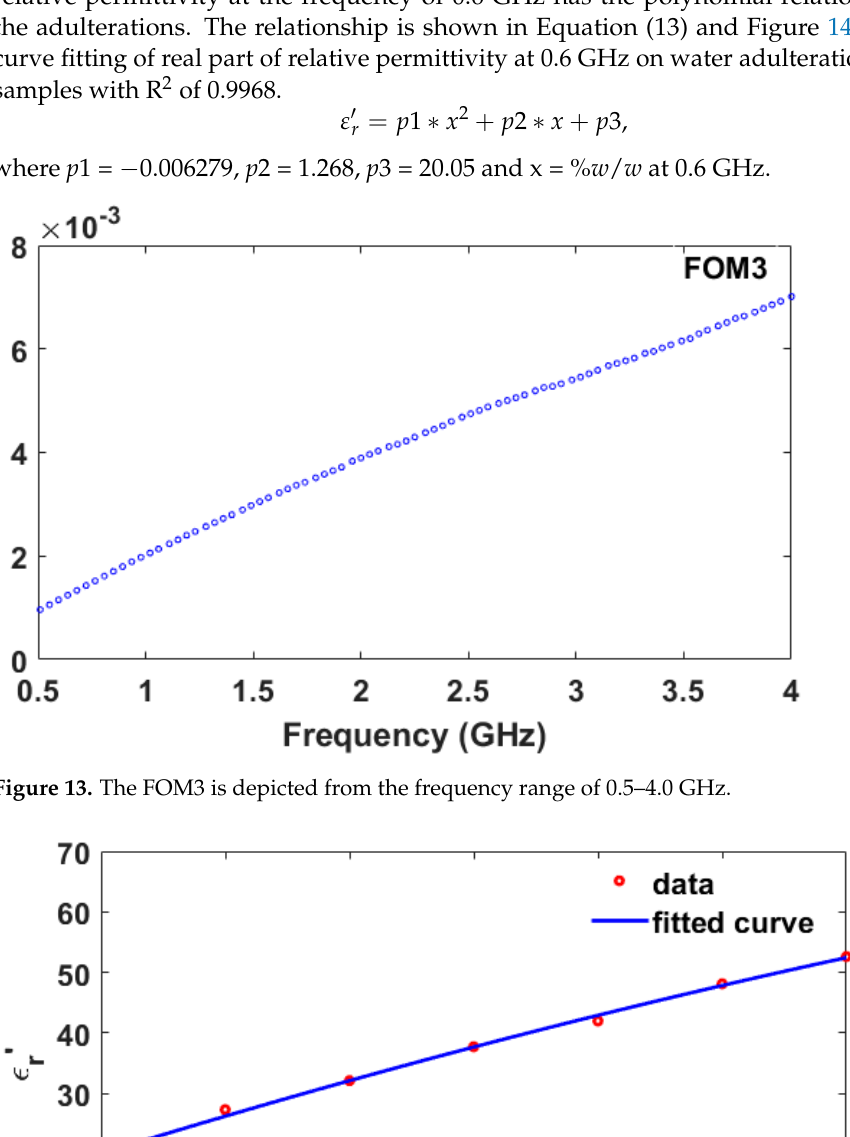
Suitable Frequency (GHz)